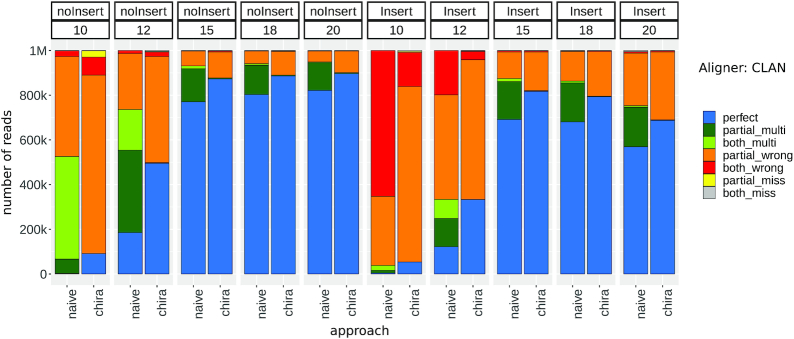
Performance of CLAN-based ChiRA compared to naive approach on benchmark data. Being a chimeric read aligner CLAN produced fewer wrong hits and more multi-mapped hits that contain the true alignment. CRL-based ChiRA could pick the correct reference from the multi-mapped hits for any arm length. Note that although there are more multi-hits (green) in naive mode compared to chira mode, the origin of these reads is still uncertain.